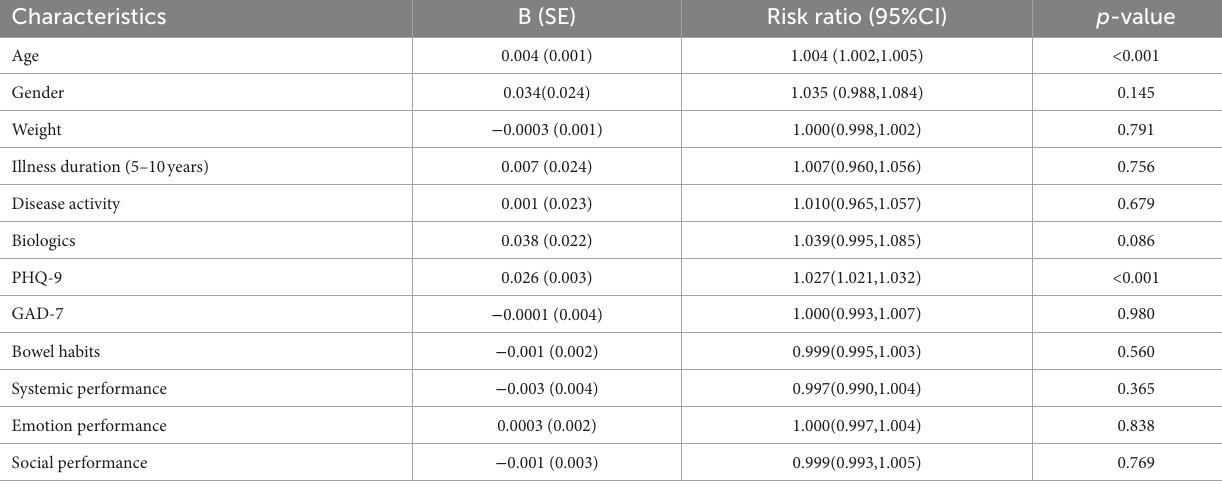
TABLE 6 Risk factors of the severity of poor sleep quality derived from the zero-inflated negative binomial regression analysis.